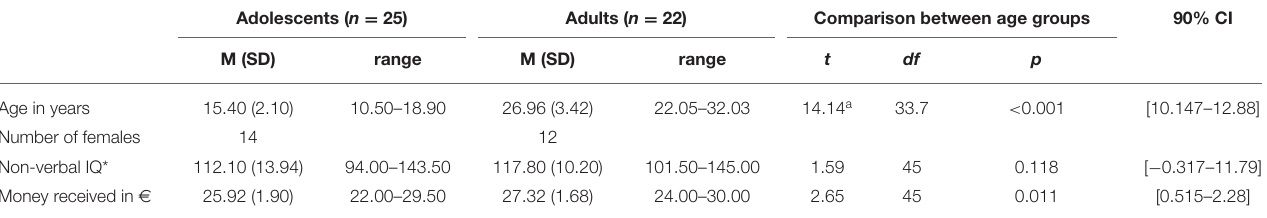
TABLE 1 | Participant characteristics ( n = 47).